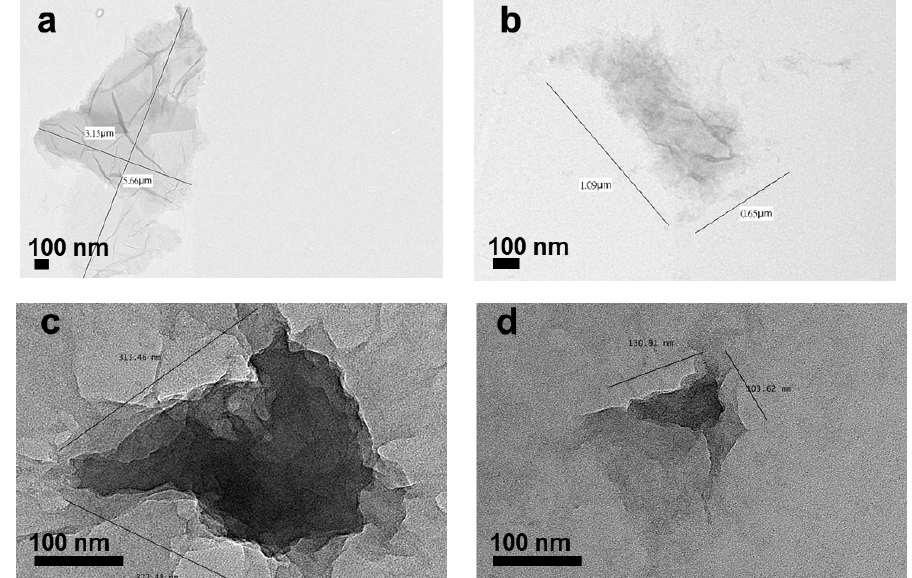
Figure 2. TEM images of GO samples with various sizes: ( a ) >1 µm, ( b ) ~1 µm, ( c ) 100 nm to 1 µm and ( d ) ~100 nm.